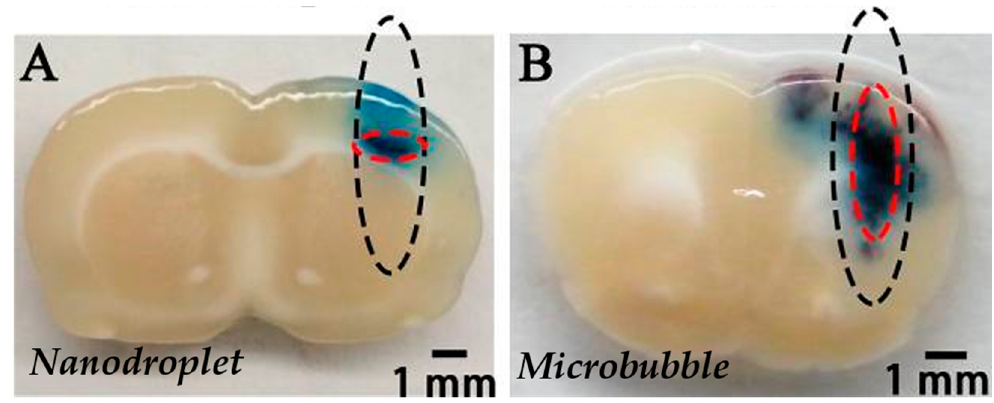
Figure 5. Distribution pattern of Evans blue extravasation when PEG-PLGA-C 5 F 12 nanodroplets ( A ) or lipid microbubbles ( B ) were used for BBB opening with FUS on male Sprague-Dawley rats. The black dotted circles show the half-maximum of the pressure amplitude of the focal zone. The red dotted circles show the deep blue region of EB extravasation, which indicates the location of the BBB opening. Extracted from Zhang et al. [80], Impact Journals, 2017.